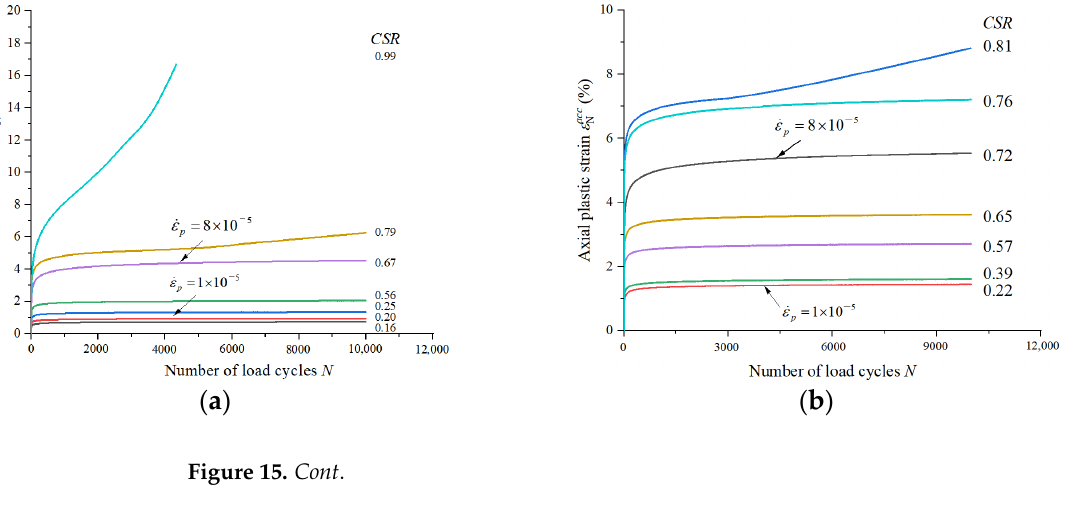
Table 2. Relationship between manner of elastoplastic response and plastic strain rate of subgrade filler.